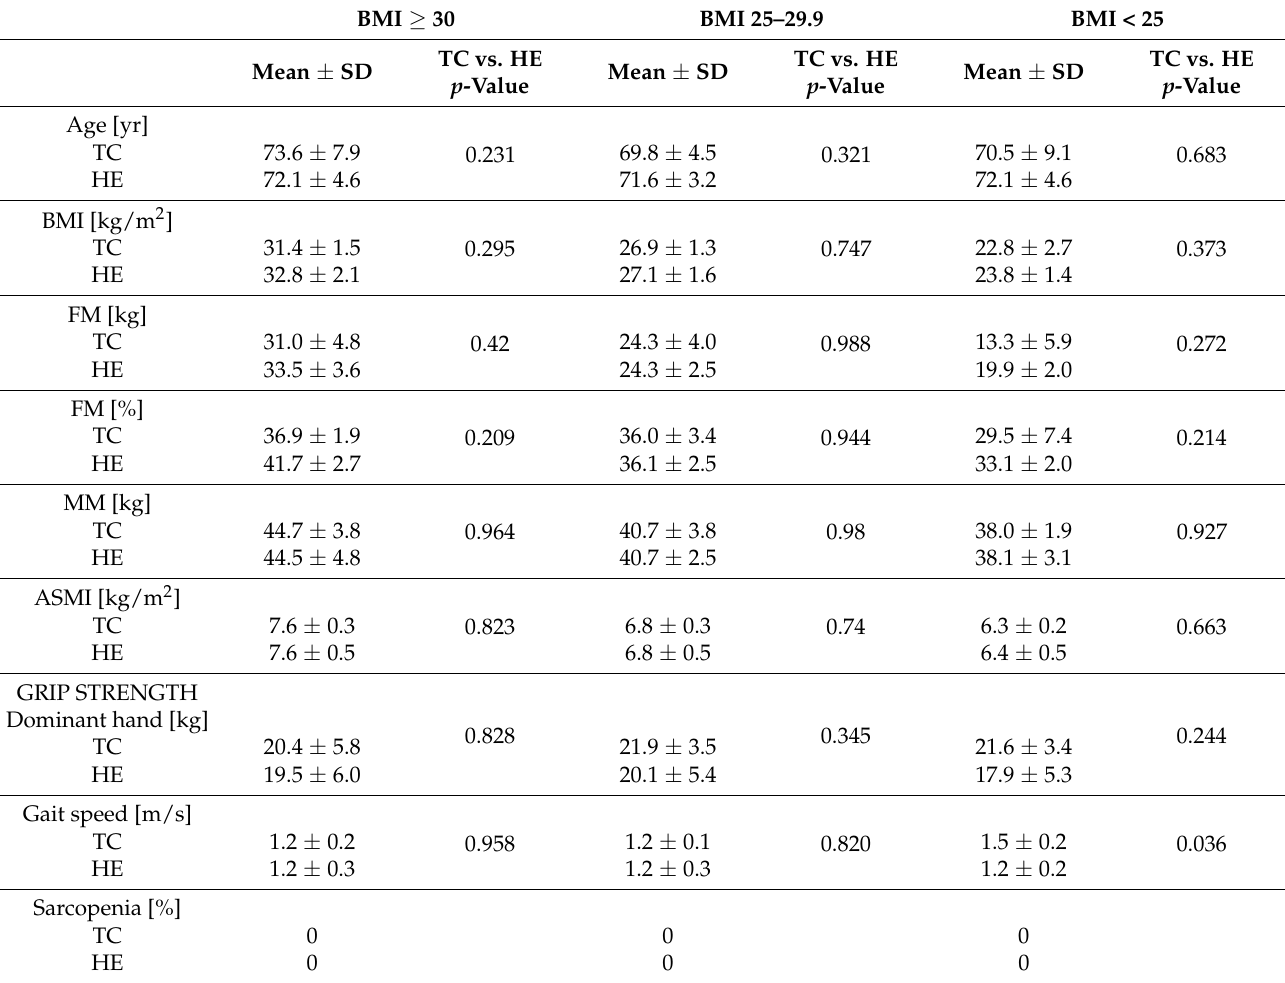
Table 2. Changes in anthropometric factors depending on BMI in both the TC and HE